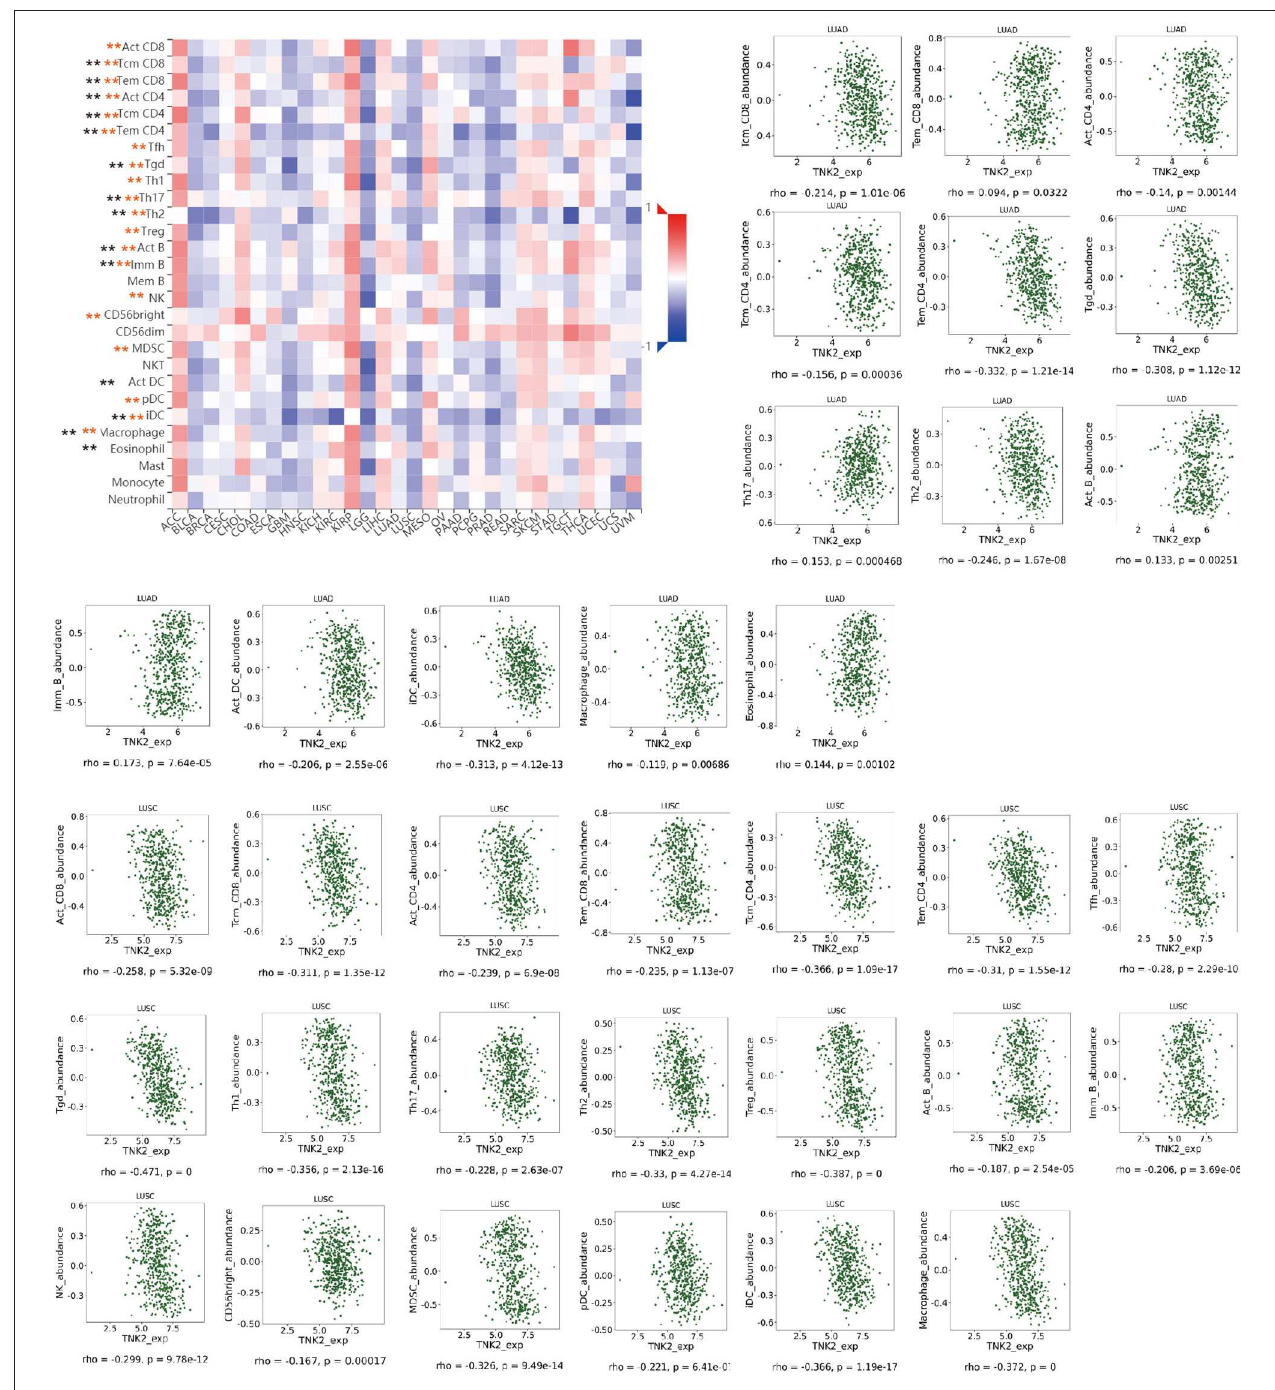
FIGURE 3 | Correlation between ACK1 / TNK2 expression levels and immune cell subsets. The black and red asterisks in the correlation heatmap indicated immune cell types significantly associated with ACK1 / TNK2 expression levels in LUAD and LUSC cohorts, respectively. The dot plots displayed the correlations between ACK1 / TNK2 expression levels and immune cell subsets in LUAD (upper panel) and LUSC (low panel). * p < 0.05; ** p < 0.01.